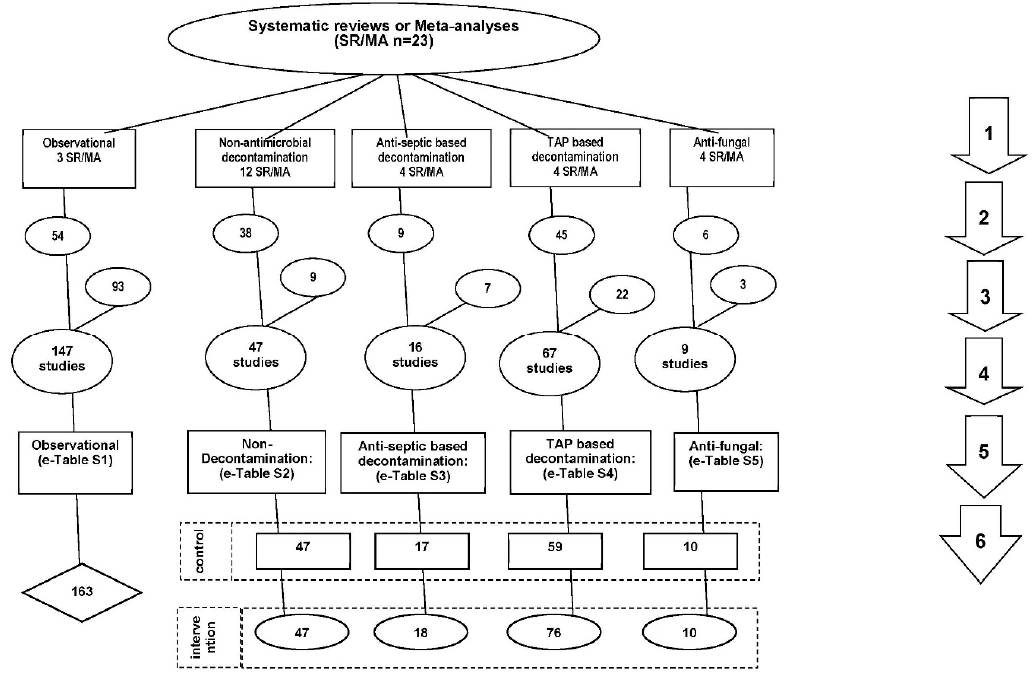
Figure 1. Search method, screening criteria and resulting classification of eligible studies and subsequent decant of component groups. The four numbered arrows are as follows; An electronic search for systematic reviews or meta-analysis (SR/MA) containing potentially eligible studies using search terms; “ventilator associated pneumonia”, “mechanical ventilation”, “intensive care unit”, each combined with either “meta-analysis” or “systematic review” up to December 2018. The systematic reviews were then searched for studies of patient populations requiring prolonged (>24 h)